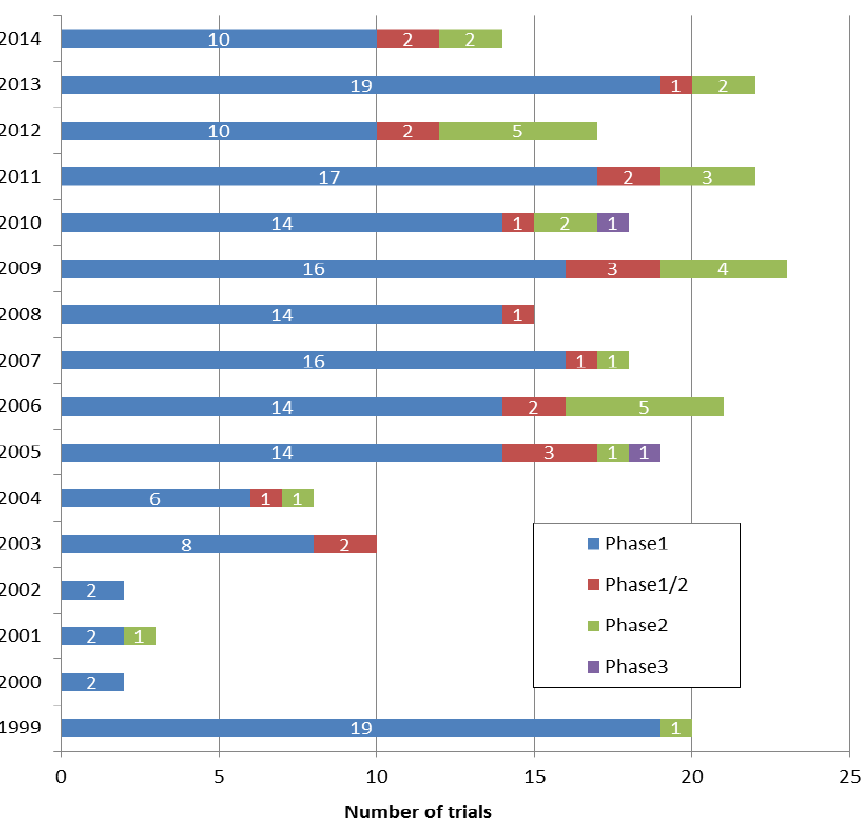
Figure 1. Number of clinical trials registered per year.